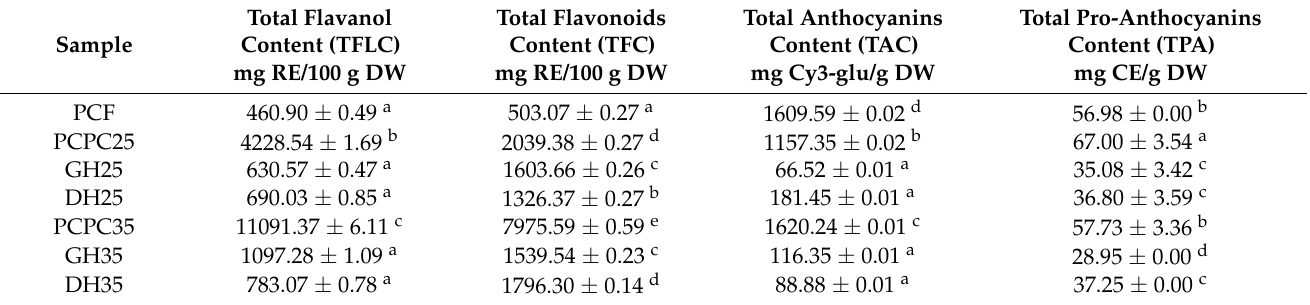
Table 2. Quantification of biocompounds of PCF, PCPC25, PCPC35 and their hydrolysates (GH25, DH25, GH35 and